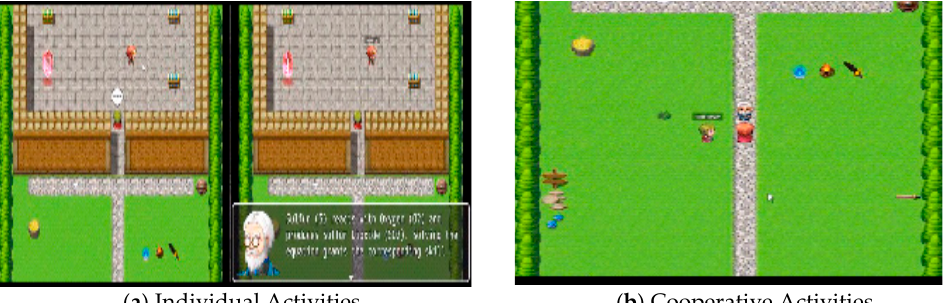
Figure 2. Examples on Cooperative and Individual Activities of MSGs ( a ) Harold on the left is balancing the copper oxidation equation to be rewarded with the copper oxidation skill while Therese on the right screen is assigned to individually balance the sulfur oxidation equation and acquire the sulfur oxidation skill ( b ) The game party is guided by an NPC to perform the experiments and observe their results, in a free form.